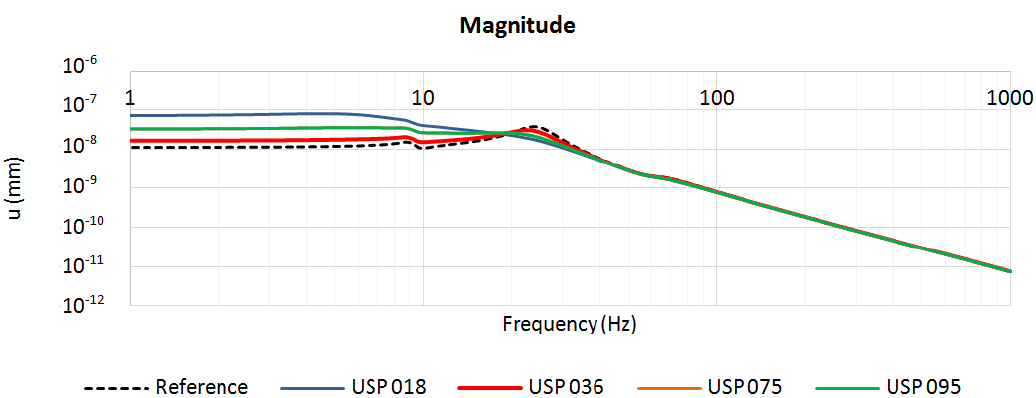
Figure 4. Magnitude of the rail head vertical displacement: reference system and systems with four analyzed USP.